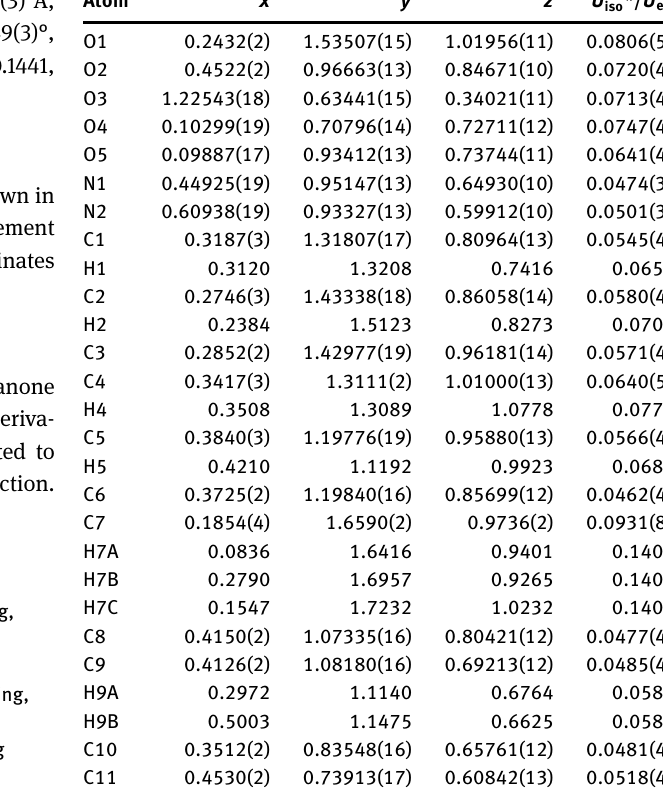
Table 2: Fractional atomic coordinates and isotropic or equivalent isotropic displacement parameters (Å 2